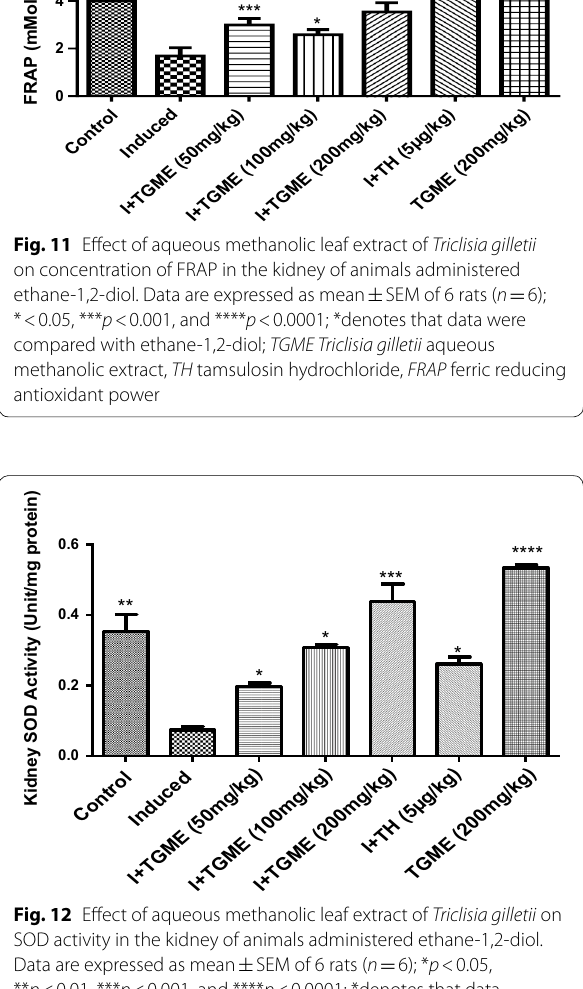
Most proteins are too large to pass through the kidney filter into the urine unless the kidney is damaged. The main protein that is mostly filtered is albumin. Increased proteinuria, albuminuria, and glucosuria in this study indicate possible glomerular and tubular damage as a result of ethane-1,2-diol administration. The protectivity of TGME on the renal epithelial could be ascribed to the antioxidant power of quercetin and oleanolic acid pre- sent in the plant [12].